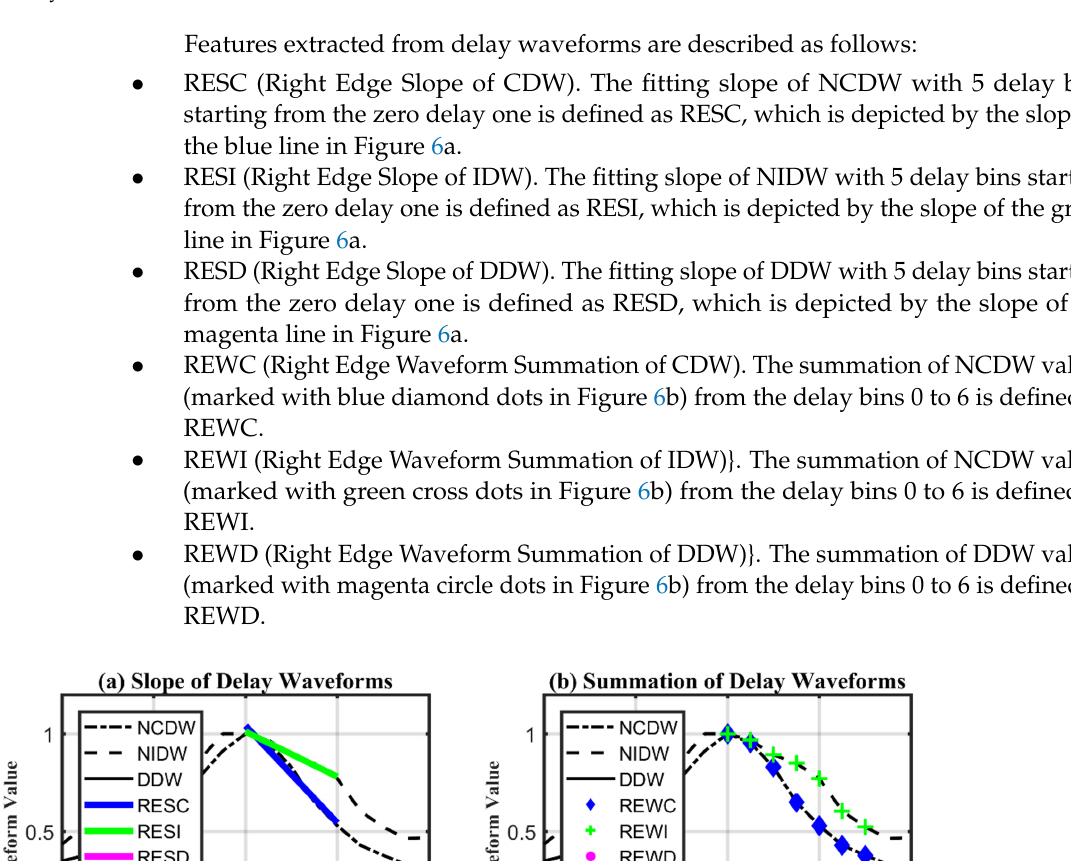
Figure 5. ( a ) Normalized central delay waveform (NCDW), ( b ) normalized integrated delay waveform (NIDW), and ( c ) differential delay waveform (DDW) of samples over open water (OW), first-year ice (FYI), and multi-year ice (MYI) surfaces respectively.